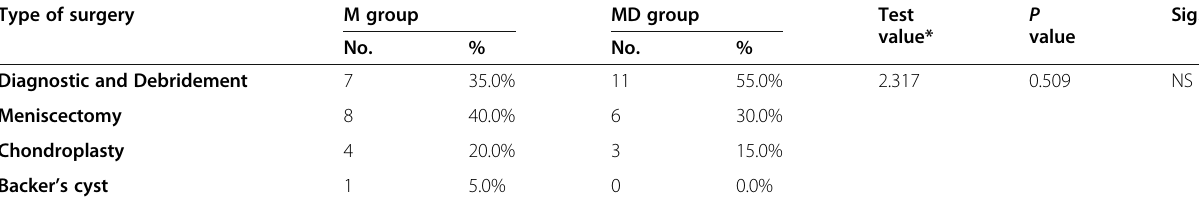
Table 2 Type of surgery Type of